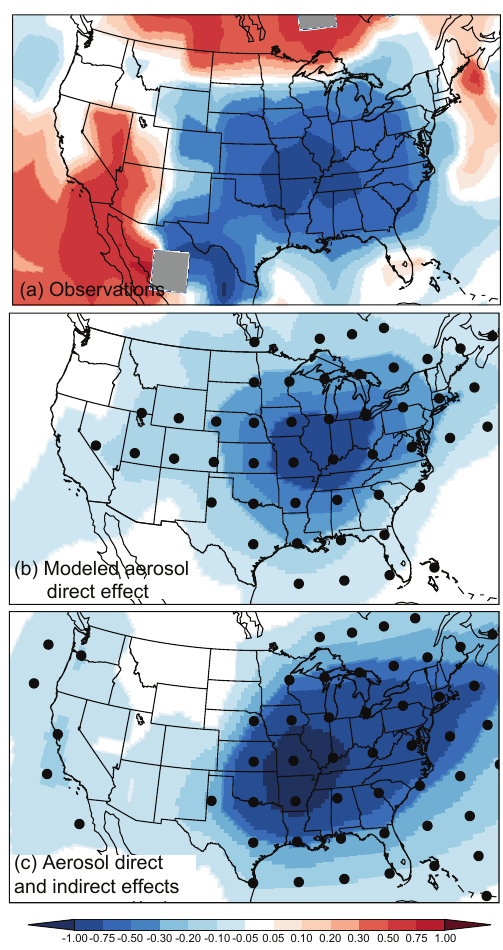
Figure 3. Observed difference in surface air temperature between 1930 and 1990 (a) and modeled effect of US anthropogenic aerosol sources on surface air temperatures for the 1970–1990 period when US aerosol loading was at its peak ( b and c ; Leibensperger et al., 2012a). Observations are from the NASA GISS Surface Tem- perature Analysis (GISTEMP; http://data.giss.nasa.gov/gistemp/). Model values represent the mean difference between 5-member ensemble GCM simulations including vs. excluding US anthro- pogenic aerosol sources and considering the aerosol direct only (b) and the sum of direct and indirect effects (c) . In (b) and (c) , dots indicate differences significant at the 95th